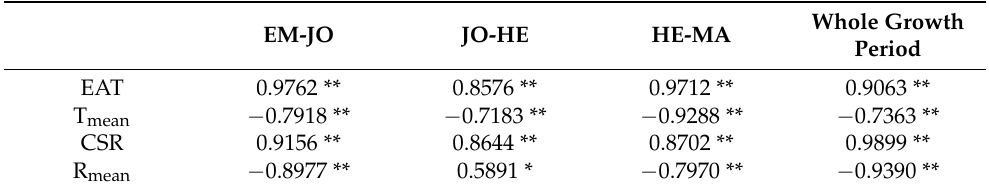
Table 8. Correlation between temperature and radiation on dry matter of spring wheat in different periods at Donghai County. Whole Growth EM-JO JO-HE HE-MA Period EAT 0.9501 ** 0.6463 ** 0.9745 ** 0.9451 ** T mean − 0.9444 ** − 0.6159 * − 0.9579 ** − 0.7970 ** CSR 0.9666 ** 0.6324 * 0.9823 ** 0.9862 ** R mean − 0.9630 ** − 0.3131 0.3365 − 0.9445 **